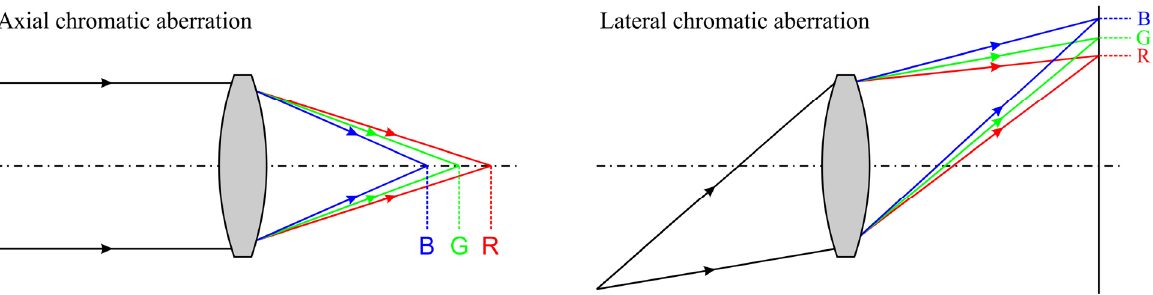
Figure 1. Axial chromatic aberration and lateral chromatic aberration